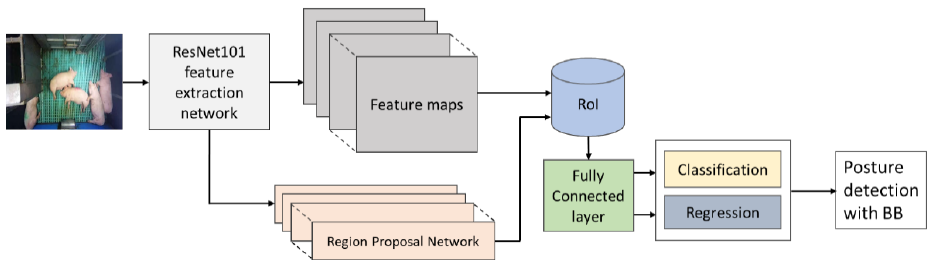
Figure 4. Architecture of Faster R-CNN.